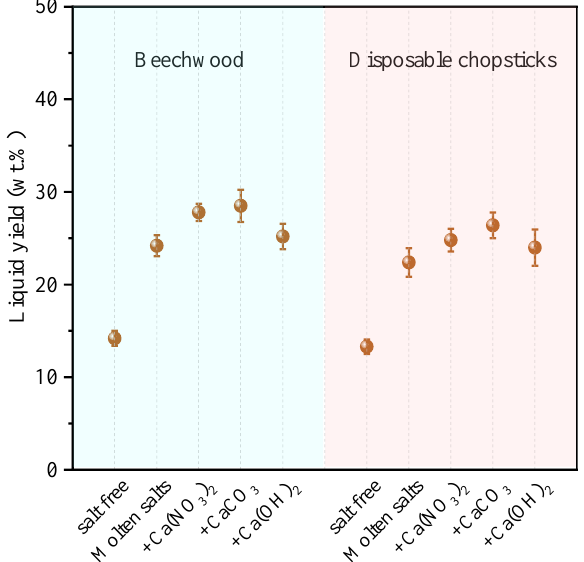
Figure 6. Liquid yield of thermal conversion in molten salts with different Ca-compounds. In order to clearly explain the release characteristics of small molecule gas, the major organic composition of liquid products from the two bio-wastes were analyzed, as pre- sented in Figure 7. CG-MS was used to test the composition and relative content of liquid products, and the major organic composition matter by functional group classification statistics. In this experiment, the liquid products were mainly divided into furan, alde- hyde ketone, phenol, aromatic hydrocarbon and nitrogen-containing compounds. For the beech wood and disposable chopsticks, the introduction of Ca(NO 3 ) 2 , CaCO 3 , and Ca(OH) 2 inhibited the formation of furan and phenols, while it enhanced the formation of ketones/aldehydes. Ca-compounds will reduce the formation of oxygen-containing com- pounds (like phenols), because Ca-compounds can enhance the deoxygenation reaction of bio-waste pyrolysis [43,44]. The catalytic action of Ca can promote the formation of ketones/aldehydes by ring opening and cracking of aromatic rings [45,46]. Figure 7. Liquid products of thermal conversion in molten salts. Moreover, in order to explore the effect of Ca-compounds on the saturation level of liquid products, the ratios of C/H in liquid products in different molten salts systems were calculated, as shown in Figure 8. The curves of the C/H ratios in liquid products were calcu- lated after removing the O atom for those molten salts systems. O atoms in liquid products could be removed according to the following routes. First, The -OH was removed due to the internal dehydration reaction. Secondly, CO 2 was produced by the cleavage/reforming of carboxyl (O-C=O) and carbonyl (C-O-C) groups. Thirdly, CO was mainly generated by cleavage of lignin units and diaryl ether bonds and ether bridges [47,48]. In general, the saturation level of the liquid phase product was inversely proportional to the C/H ratio in liquid products, and the change of C/H ratio in liquid products was used to characterize the changing trend of the saturation level of the liquid product. A higher C/H ratio in liquid products corresponds to a lower saturation level. From Figure 8, it could be seen that the C/H ratio in liquid products corresponding to the highest content decreased with the addition of Ca-compounds, which indicates that Ca 2+ can promote the saturation level of liquid products. As mentioned above, compared to NaNO 3 -NaNO 2 system, the addition of Ca-compounds will decrease the yield of H-containing gases, and in turn promote the saturation level of liquid products. In addition, the degree of decrease for the C/H ratio in liquid products is as follows: Ca(NO 3 ) 2 > CaCO 3 > Ca(OH) 2 . Compared with Ca(NO 3 ) 2 , CO 3 2 − and OH − were introduced in NaNO 3 -NaNO 2 salt for CaCO 3 and Ca(OH) 2 ,